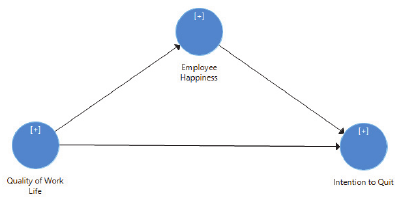
Fig. 1. Research conceptual